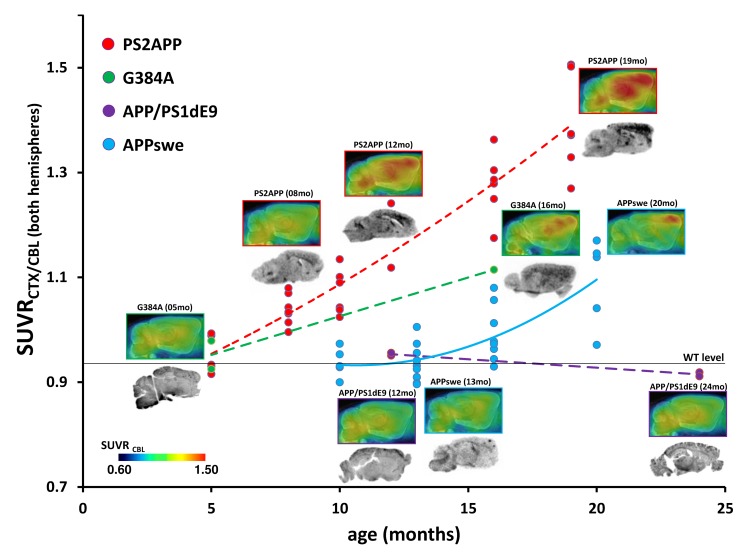
Multi-modal analysis of the four AD mouse strains studies in this cross-sectional [18F]-florbetaben PET study.Upper images represent group averaged sagittal PET slices, normalised to the cerebellum and overlayed on an MRI mouse atlas [39]. Dots indicate corresponding assessments of SUVRCTX/CBL in individual mice. Dashed lines express the estimated time dependent progression in PS2APP (red; five months: N = 5; eight months: N = 7; 10 months: N = 6; 12 months: N = 2; 16 months: N = 6, 19 months: N = 6), G384A (green; five months: N = 2; 16 months: N = 1) and APP/PS1dE9 (purple; 12 months: N = 2; 24 months: N = 2) mice, fitted with a polynomial function (for the purposes of illustration). Longitudinal progression in APPswe mice is indicated by a continuous blue line. Lower images depict representative ex vivo autoradiography results; autoradiography of APP/PS1dE9 mice and young G384A mice was performed in vitro. WT level expresses the mean SUVRCTX/CBL of pooled WT mice (N = 22).